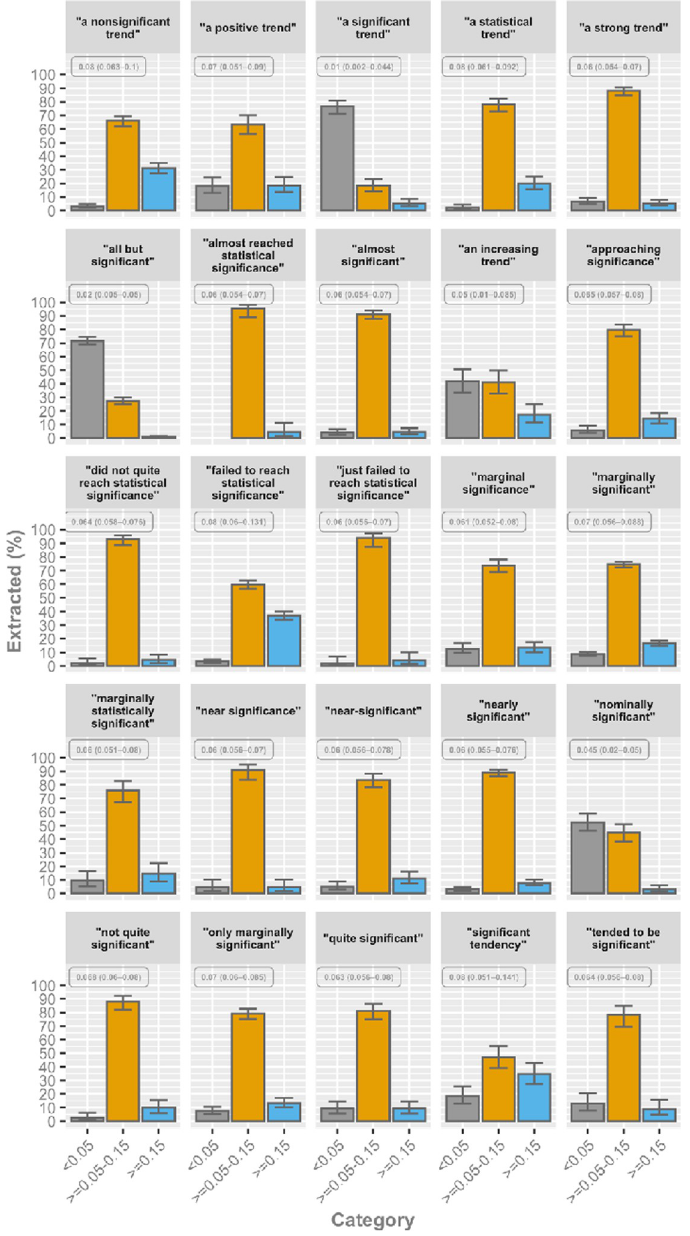
Fig 5. Category percentages for the 20 most frequent phrases describing nonsignificant results, with at least 100 manually extracted P values. Error bars represent the 95% CI. The associated median P value (with the 25% and 75% quantiles) is presented in the upper left corner of each phrase. The data can be found here: https://github.com/wmotte/ almost_significant/tree/main/Fig_and_Data. CI, confidence